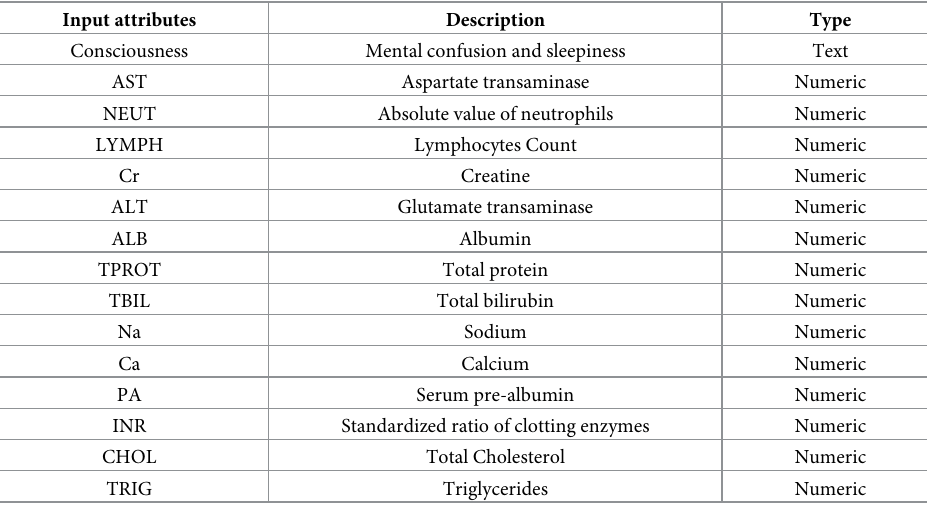
Table 2. Description of input parameters characteistics.